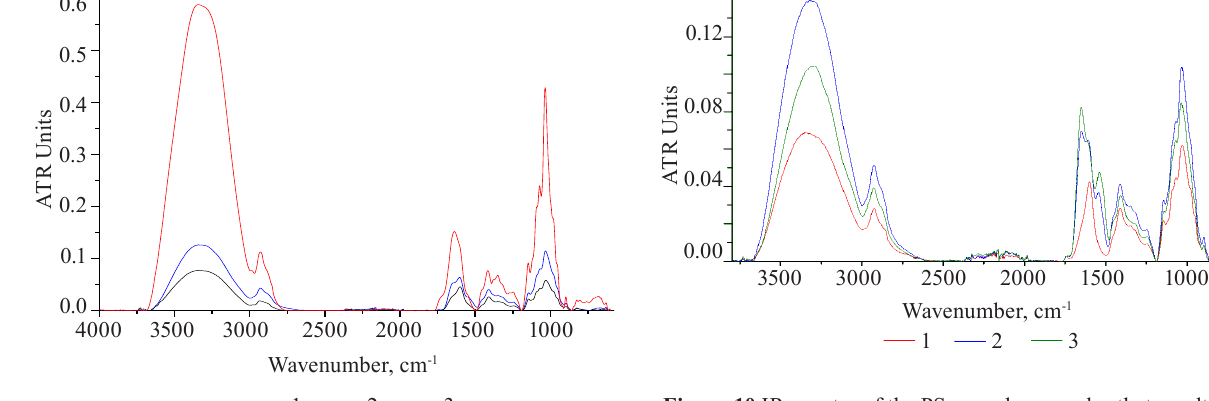
Table 3 Conditions and results of the combined sequential extraction Stage Conditions Extracted